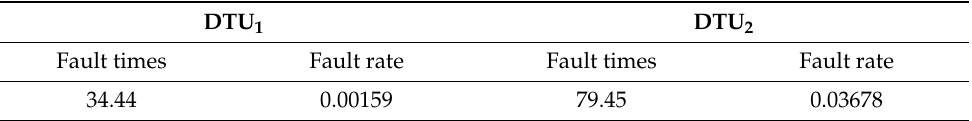
Table 6. Fault times and fault rate of two groups of DTUs.